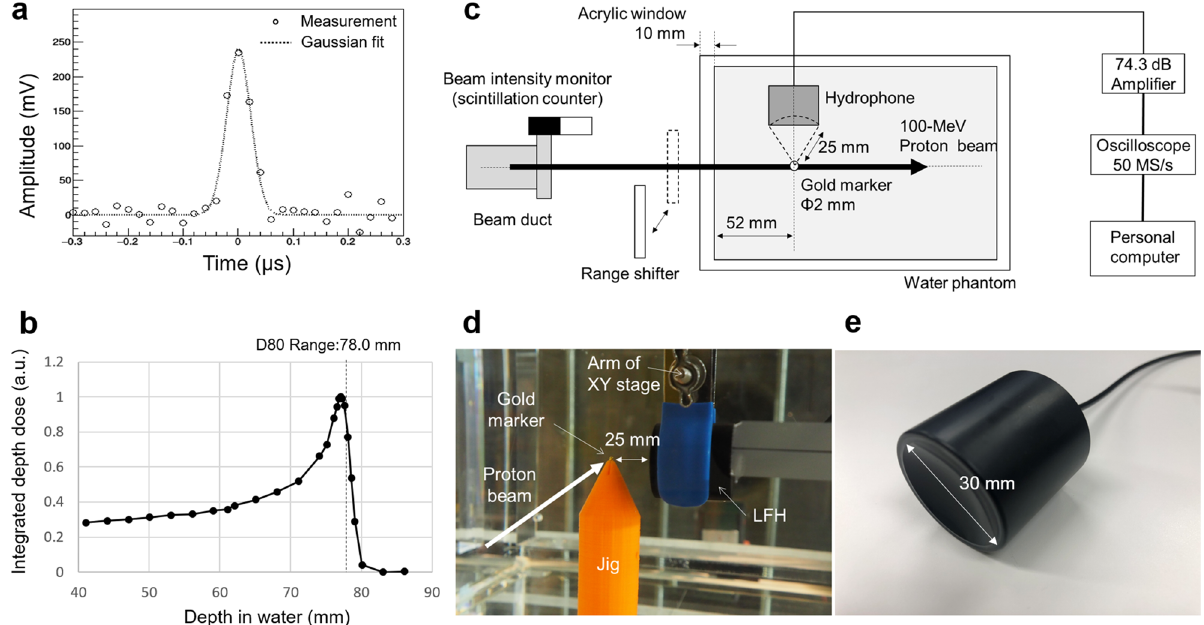
Figure 2. Experimental approach for observing the SPIRE. ( a ) The pulse shape as measured by a beam intensity monitor and ( b ) the Bragg curve as measured by an ionisation chamber. ( c ) Schematic of the experimental setup for the SPIRE measurement using an LFH. A 100 MeV pulsed proton beam produced by an FFA was injected into the water phantom at a frequency of 30 Hz. The temperature of the water was kept at 22 °C. A gold marker with a diameter of 2 mm was placed on the beam axis and the SPIRE emitted from the marker was collected by the LFH. The residual range at the marker was changed by stacking acrylic plates on the phantom surface. For each beam pulse, the shape of the pulse was monitored by counting the lost protons, stray neutrons and gamma-rays using an EJ-200 plastic scintillator mounted at the exit of the vacuum beam duct. For each separate run, the scintillator signal height was converted to the number of protons measured using the Faraday cup. ( d ) Photograph of the gold marker and hydrophone setup in the water phantom. A stand with a conical tip with a slit was made to support the gold marker underwater. The stand was made of ABS resin that had an acoustic impedance close to that of water. The hydrophones were mounted on an XY stage that can scan in a plane parallel to the beam direction; they were set at position where the pressure amplitude is maximized. ( e ) Photograph of the LFH. A PZT piezoelectric ceramic processed into a spherical shape was used to improve the sensitivity. The focal length was set to 25 mm to have the maximum solid angle centred at the marker while keeping a sufficient distance from the proton